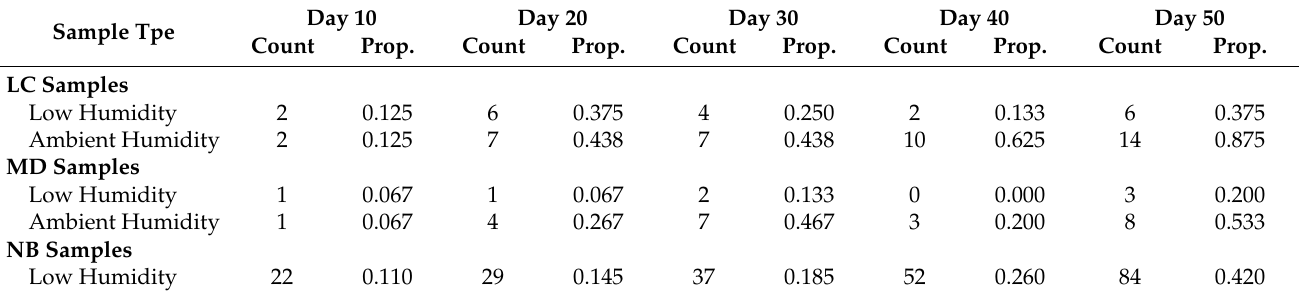
Table 3. Proportion (Prop.) and number of specimens with <80% CK-MM recovery over 50 days.